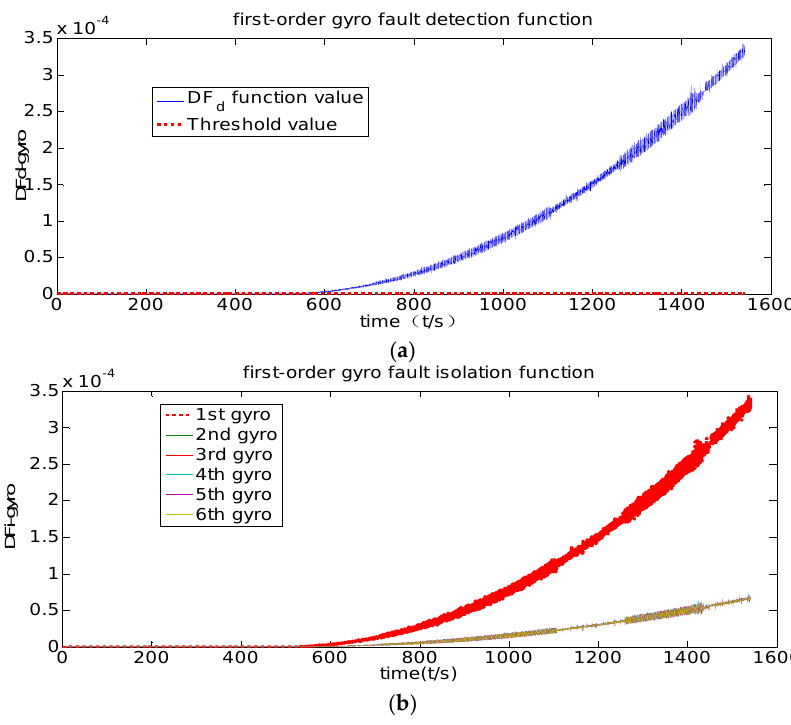
Figure 12. First ‐ order channel filter. ( a ) Fault detection; ( b ) Fault isolation.